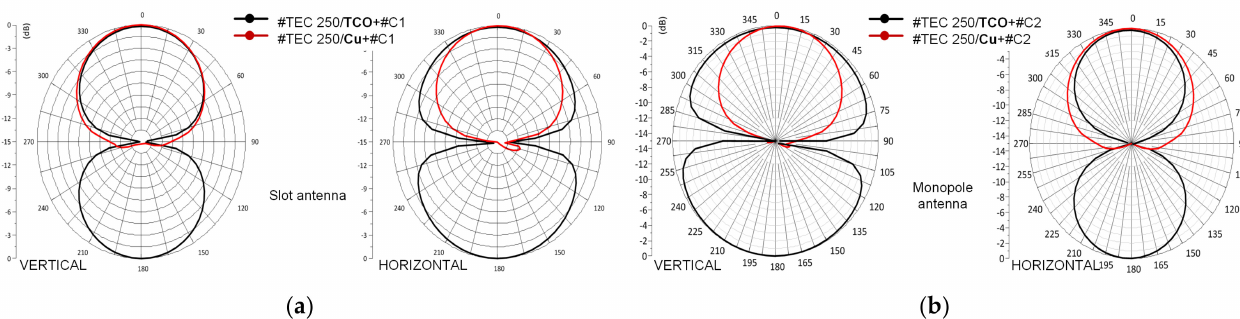
Figure 24. CMF and radiation efficiency n RAD when modelling with TCO or Cu layer: ( a ) Slot antenna #C1; ( b ) Monopole antenna #C2.